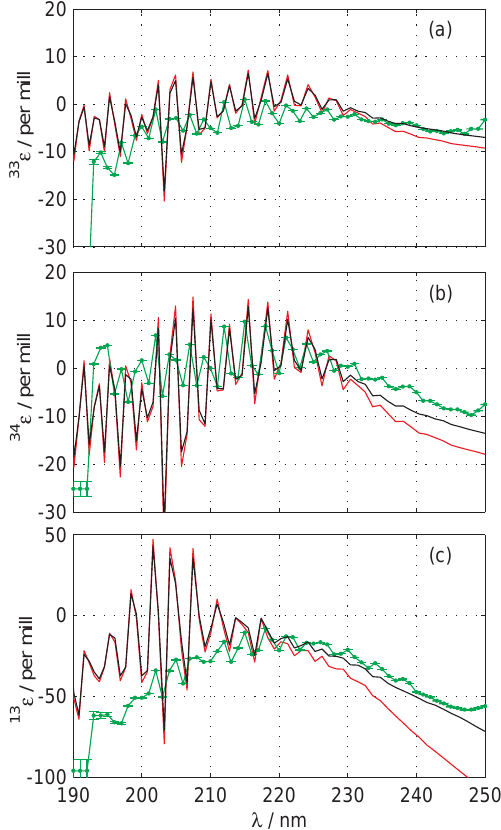
Fig. 2. (a) The calculated 33 S fractionation constant vs. wavelength at 295K (black) and 220K (red) compared to the experimental 33 S fractionation constant at room temperature (green) by Hattori et al. (2011). (b) 34 S fractionation constant. (c) 13 C fractionation con-